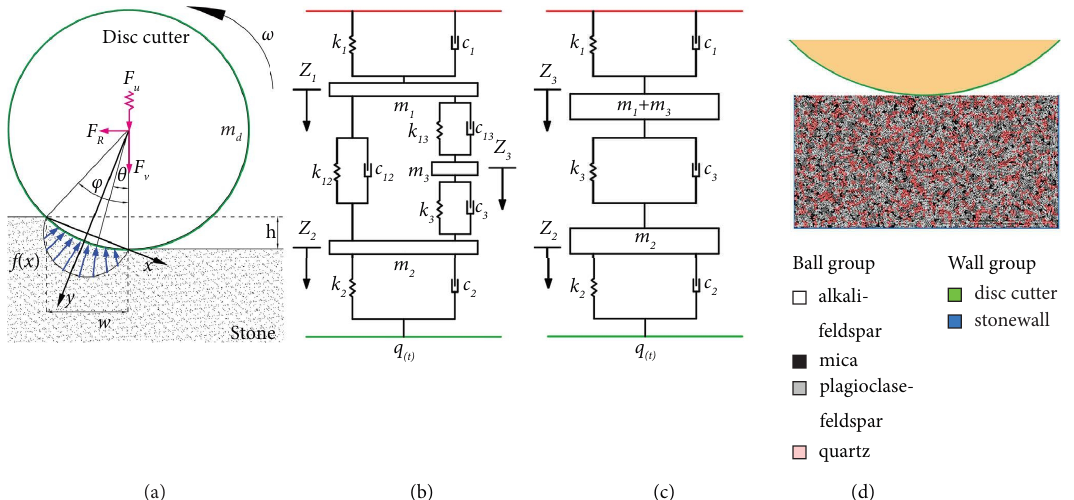
Figure 4: Rock breaking model of the disc cutter: (a) stress distribution between the rock and disc cutter, (b) physical model, (c) simplifed physical model, and (d) discrete element